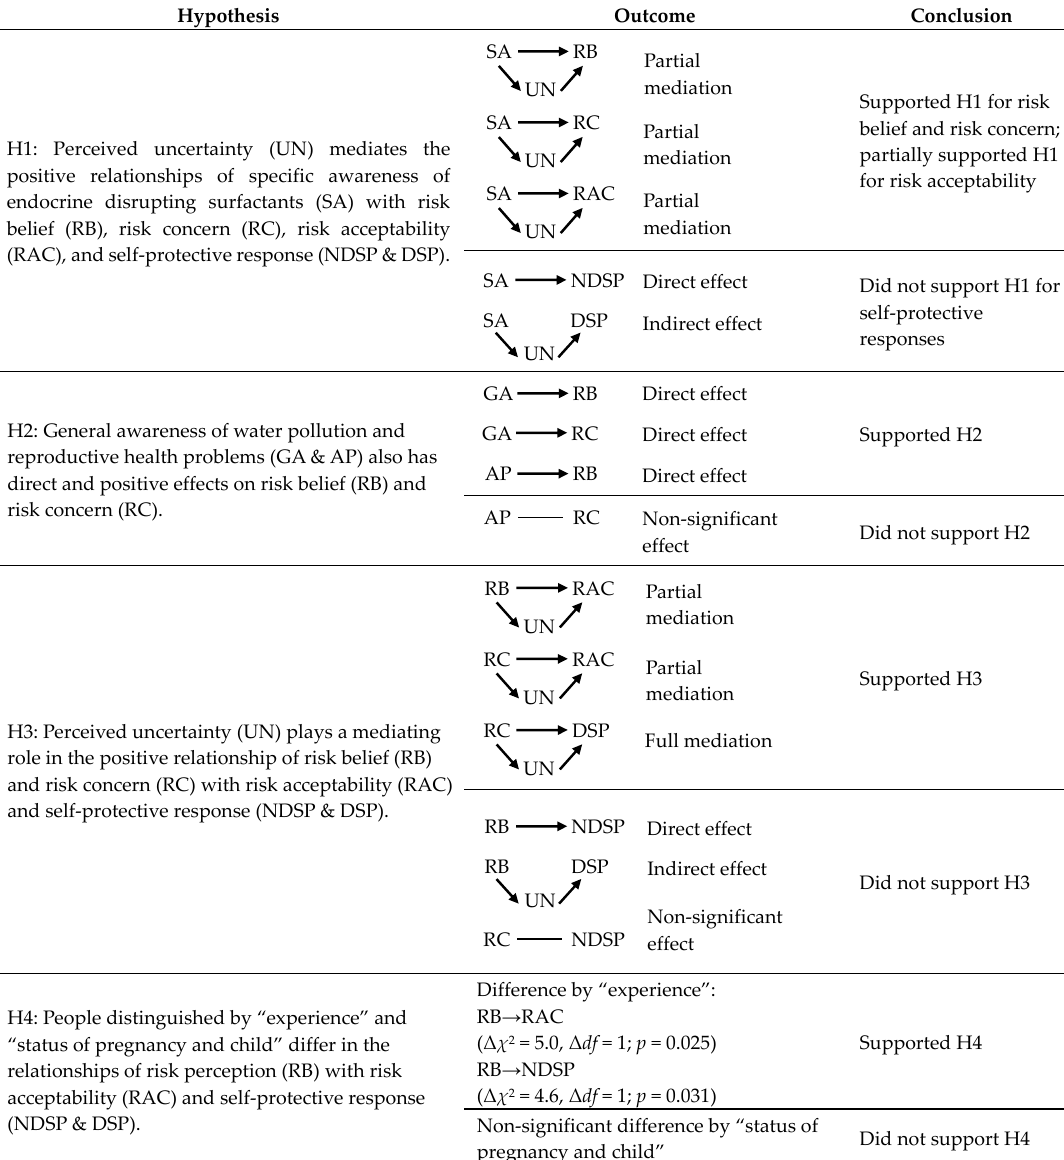
Table 5. Summary of the hypotheses and outcomes ( n = 328).